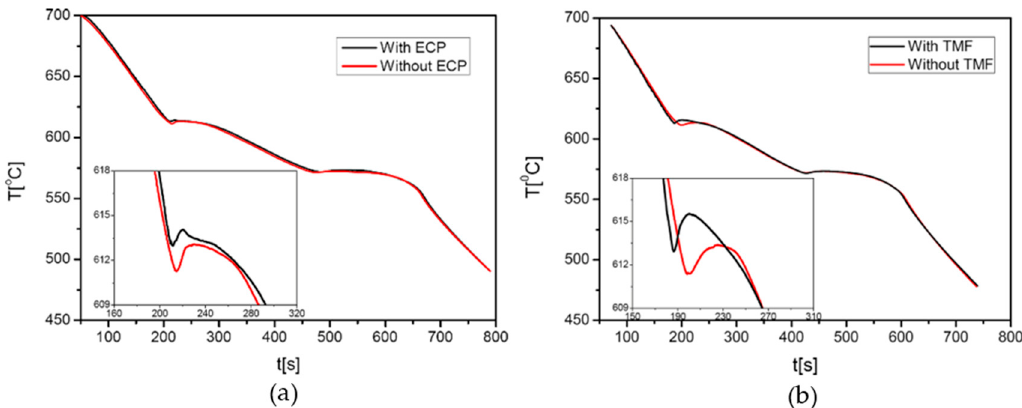
Figure 8. Cooling curves of the solidified Al ‐ 7 wt. %Si alloy measured at the height of 30 mm: ( a ) ECP; ( b ) TMF. Table 2. Influence of the applied ECP and TMF on the T Low of Al ‐ 7 wt. %Si alloy.